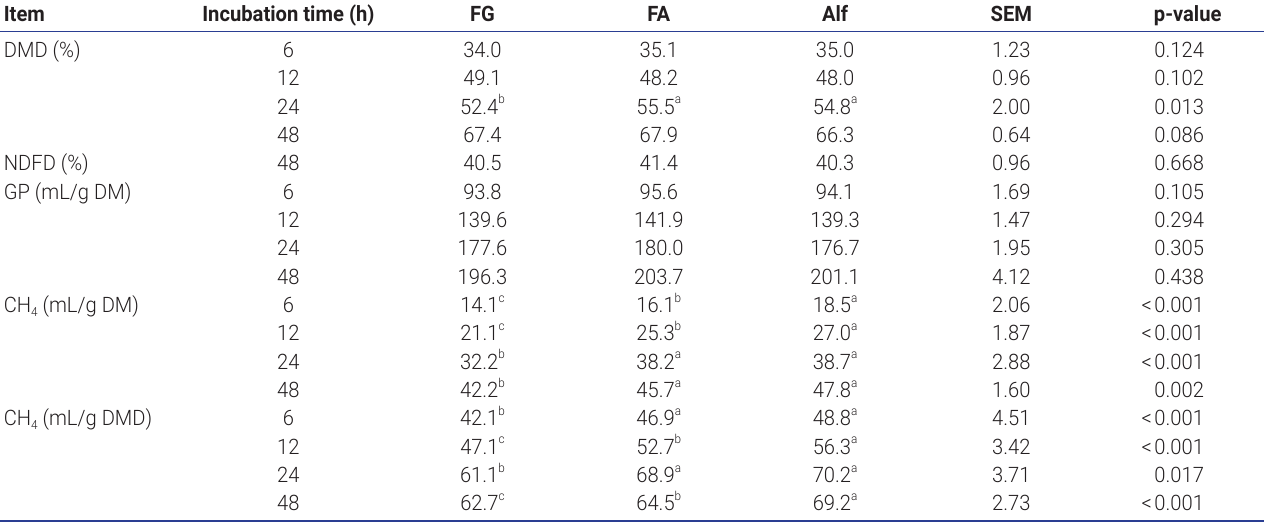
Table 4. Dry matter disappearance (DMD), neutral detergent fibre disappearance (NDFD), gas production (GP), and methane (CH ing 48-h in vitro ruminal incubation of mature forages Item